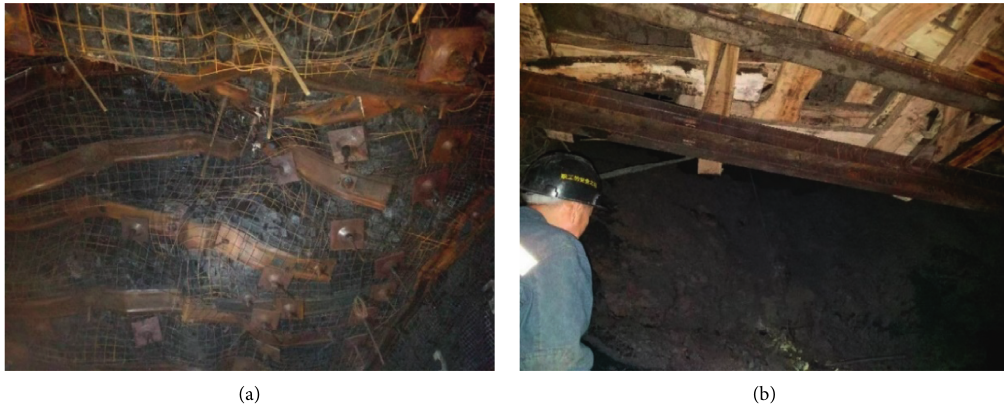
Figure 2: Photos of a seriously damaged roof. (a) Anchor cable reinforcement. (b) Shed support.